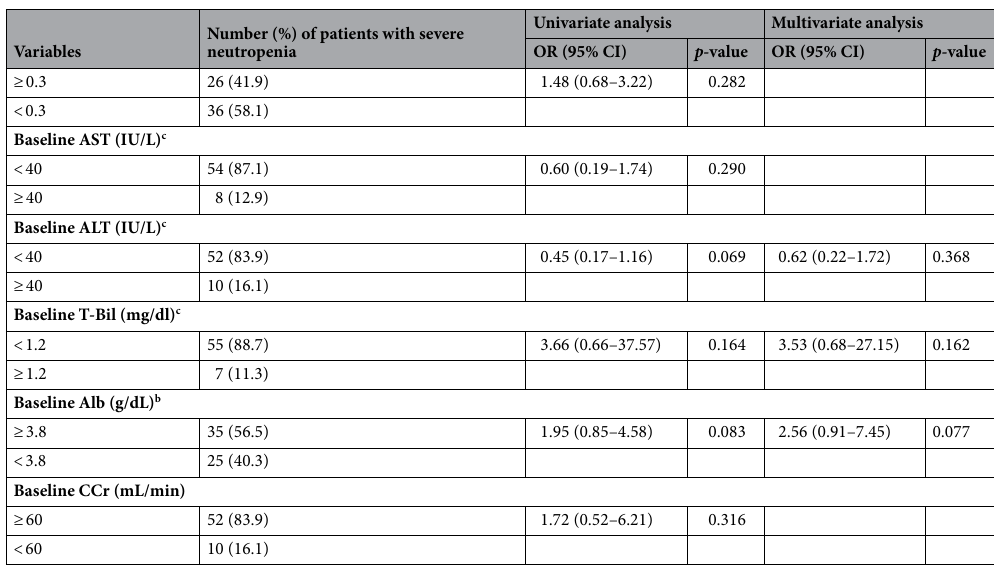
Table 4. Risk factors for severe neutropenia among 122 patients treated with mFOLFIRINOX. CI confidence interval, ECOG-PS Eastern Cooperative Oncology Group-performance status, WBC white blood cell, Neu neutrophil count, Lym lymphocyte count, Hb hemoglobin level, Plt platelet count, CRP serum level of C-reactive protein, AST serum level of aspartate aminotransferase, ALT serum level of alanine aminotransferase, T-Bil serum level of total bilirubin, Alb serum level of albumin, CCr creatinine clearance. a The median value was set as the cut-off value. b The lower limit of normal was set as the cut-off value. c The upper limit of normal was set as the cut-off